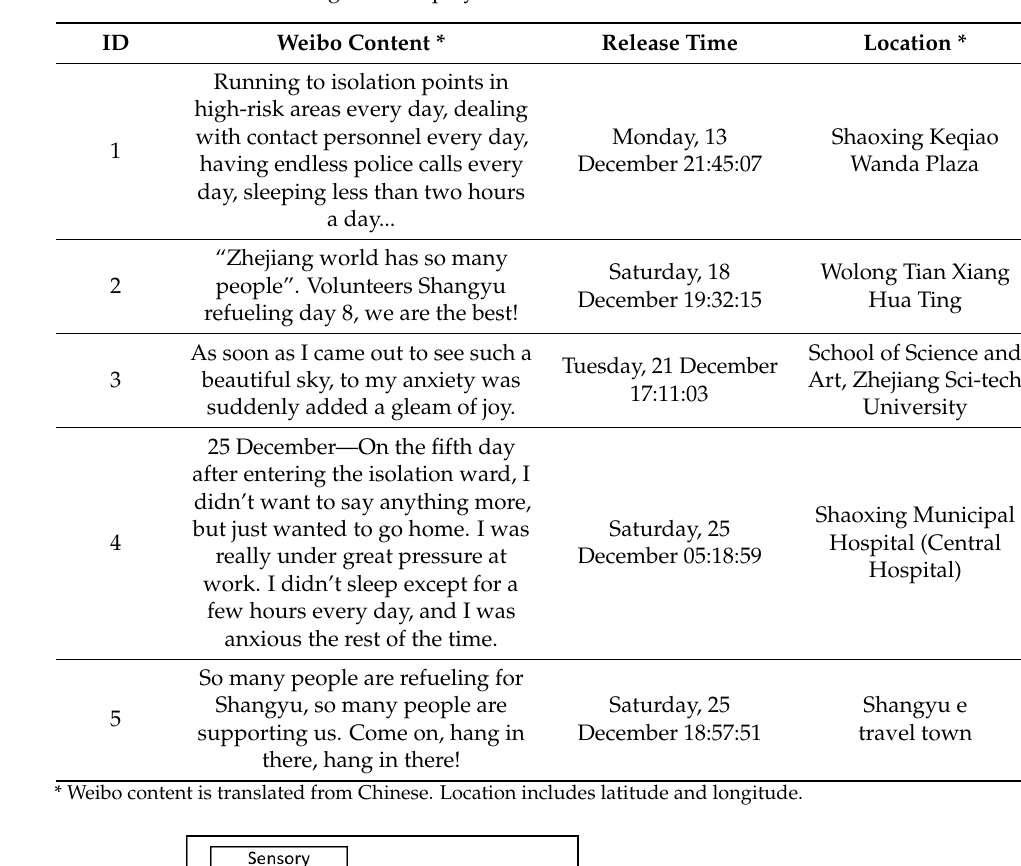
Table 1. Selected Weibo Blog Data Display.